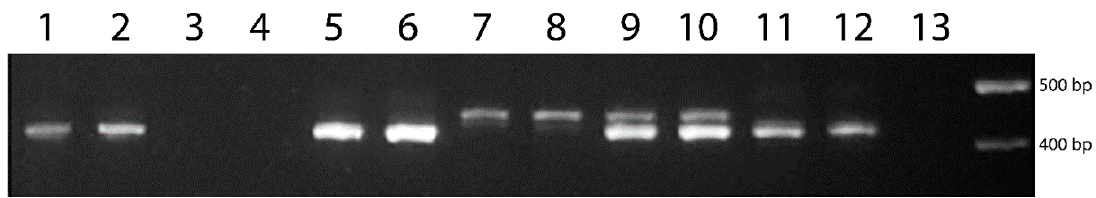
Figure 3. Amplification products obtained using WXTH marker in wheat and the studied related wild